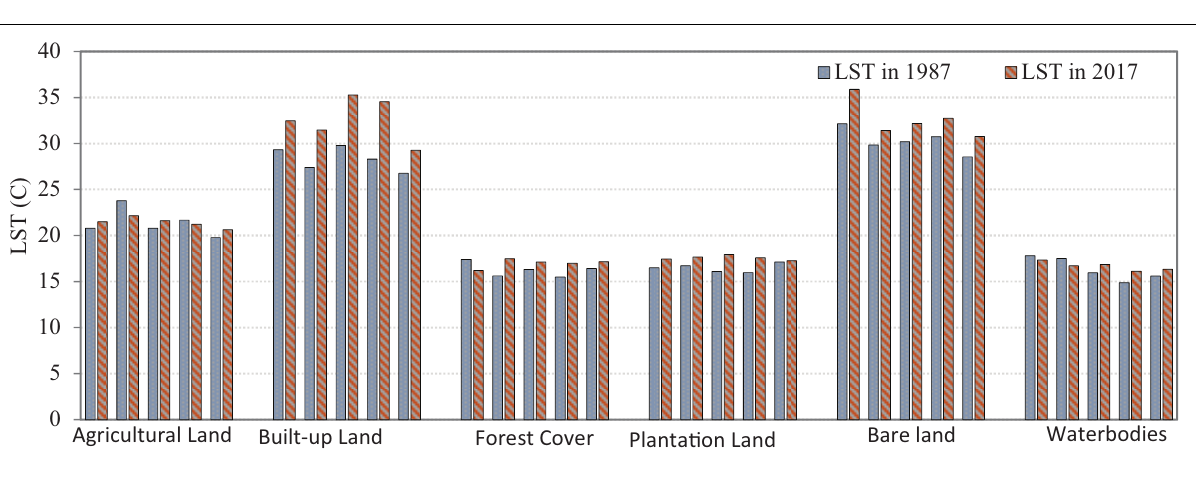
FIGURE 3 | LST of Barddhaman district (1987, 1997, 2007, and 2017). Source: Author, 2019. (Landsat 5 and 8 satellite imagery, USGS).